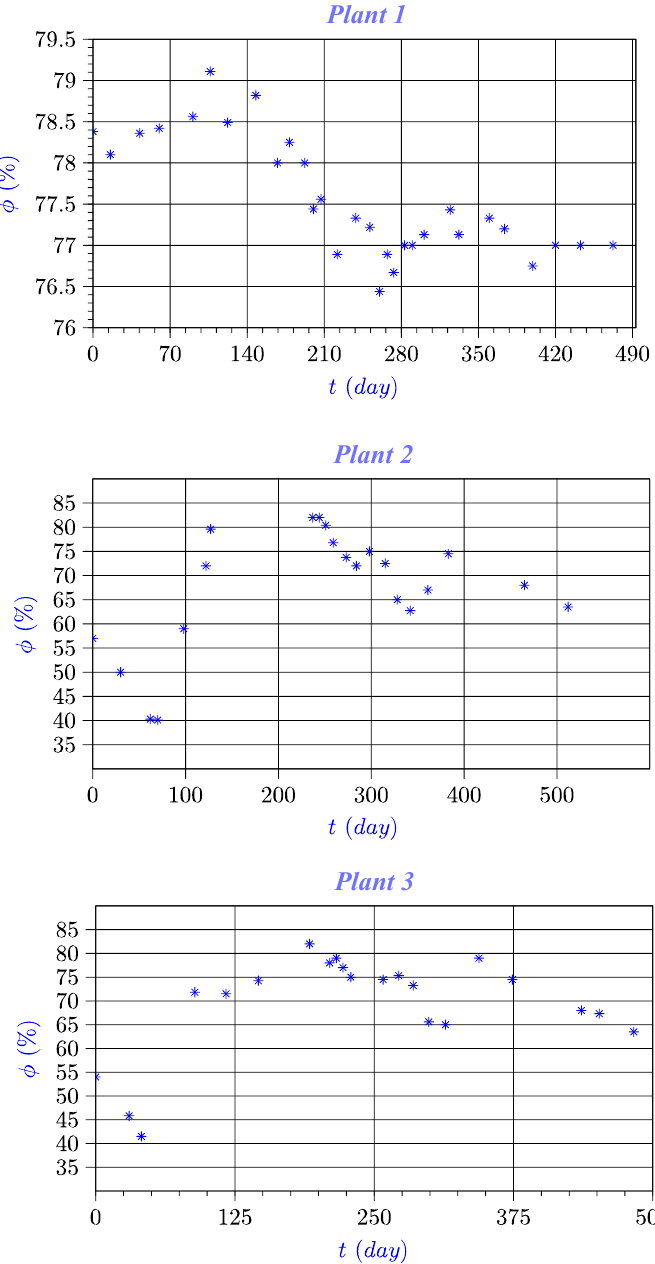
Figure A2. Relative humidity results for plants 1, 2, and